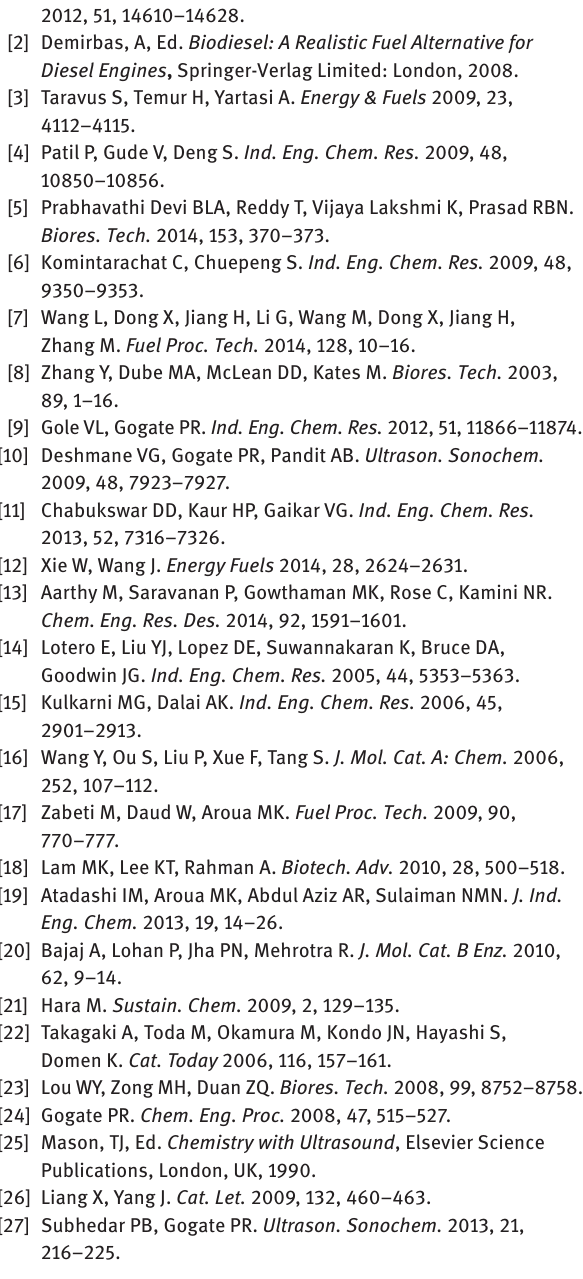
ratio of 1:6, catalyst loading of 3%, temperature of 333 K, power dissipation of 120 W, 8 s ON and 2 s OFF duty cycle and THF as a co-solvent, and gave a maximum conver- sion of 86%. Overall, the present work demonstrated a sustainable approach for the synthesis of catalyst and the subsequent biodiesel production from non-edible cheaper feedstock such as PFAD.